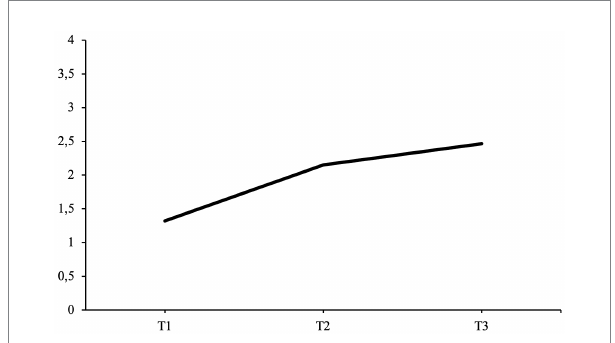
FIGURE 7 Average life story agency scores at each interview time point. T1, pre-interview; T2, post-interview; T3, follow-up